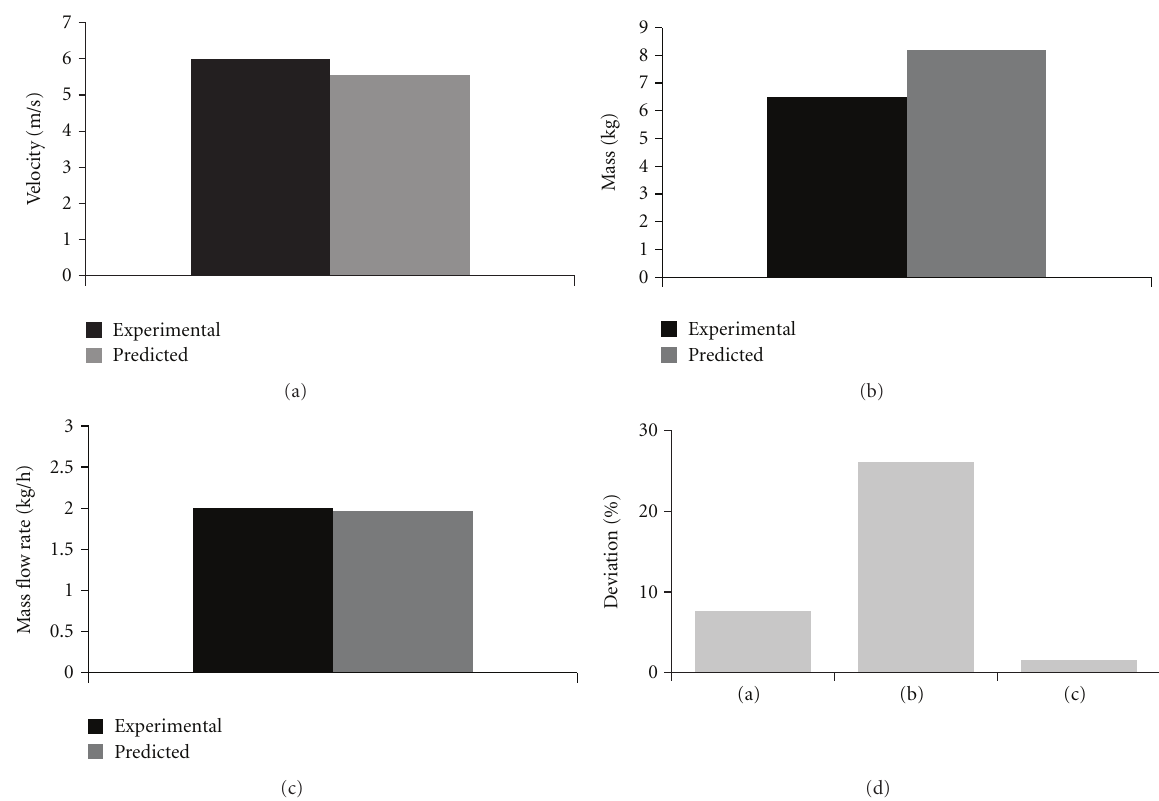
Figure 3: Comparison of the semiempirical model results for (a) superficial gas velocity ( U ), (b) solids inventory ( I ), (c) aeration mass flow rate ( m lv ), and (d) deviation for each variable.